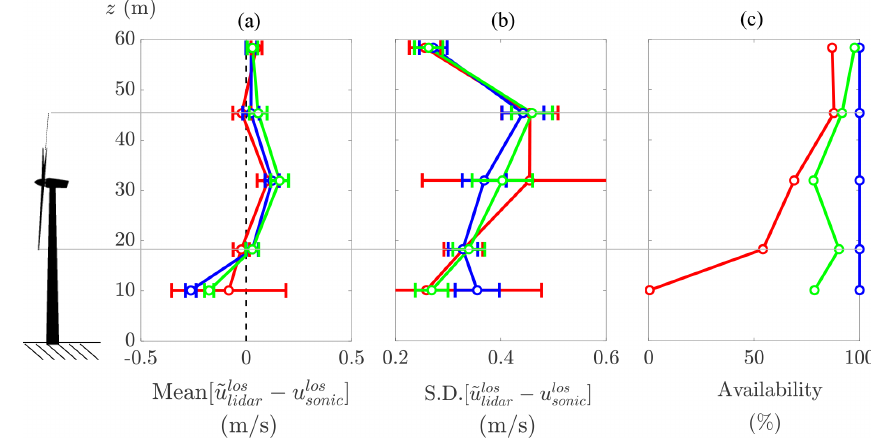
Figure 15. Aggregate results from waked cases for (a) mean error, (b) , standard deviation (SD) of error, and (c) data availability plotted versus height off the ground. The dimensions of a V27 turbine as used in the experiment are shown for reference. The line colors are thresholding (red), advanced filtering (blue), and machine learning